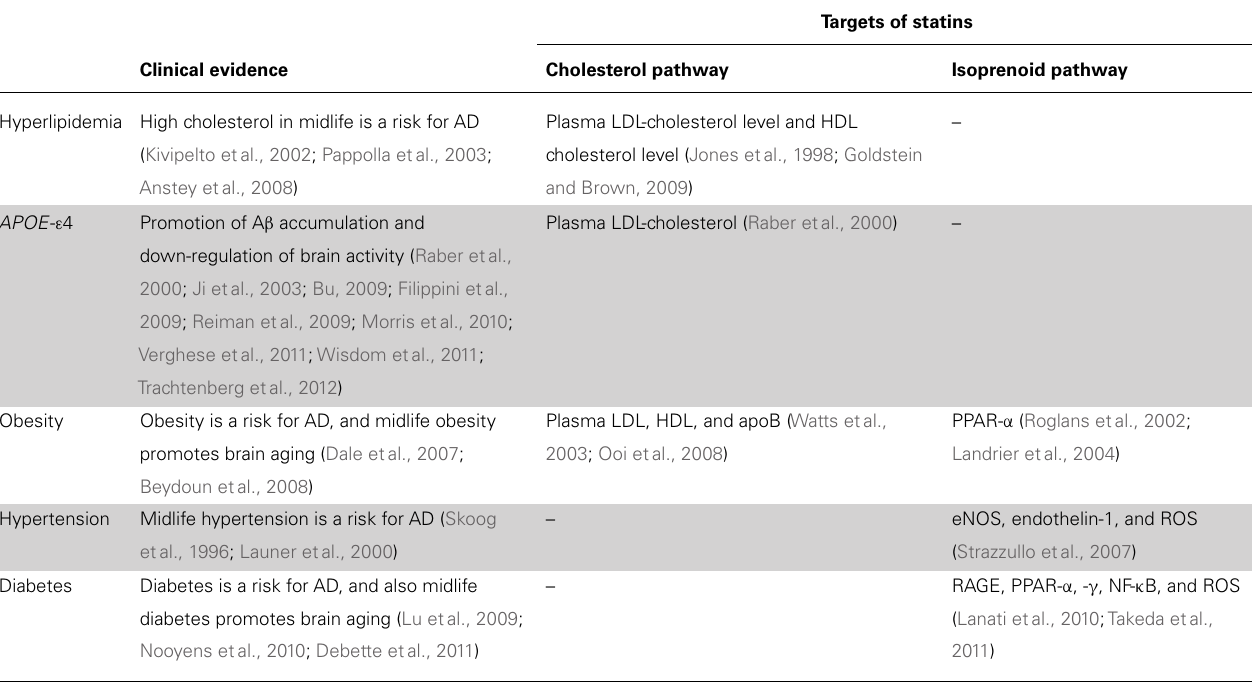
Table 1 | Summary of presumable beneficial actions of statin use in midlife onAD epidemiological factors.